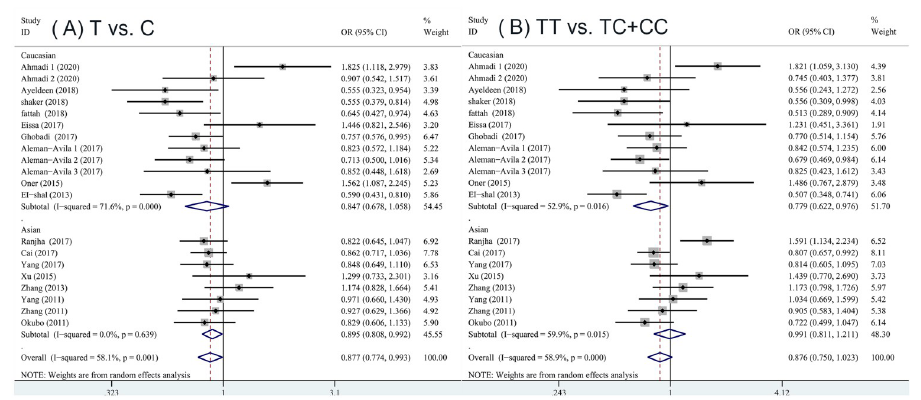
Fig 3. Stratified analysis of the association of the miRNA-499 rs3746444 polymorphisms with the autoimmune diseases by ethnicity. (A) T vs. C, (B) TT vs. TC+CC.